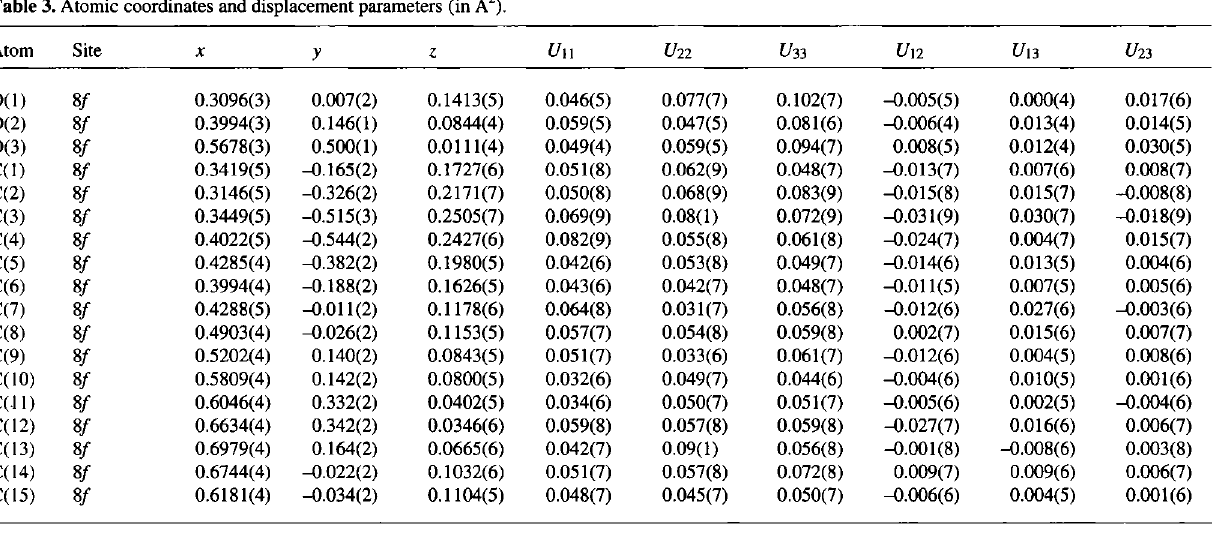
Table 3. Atomic coordinates and displacement parameters (in Â 2